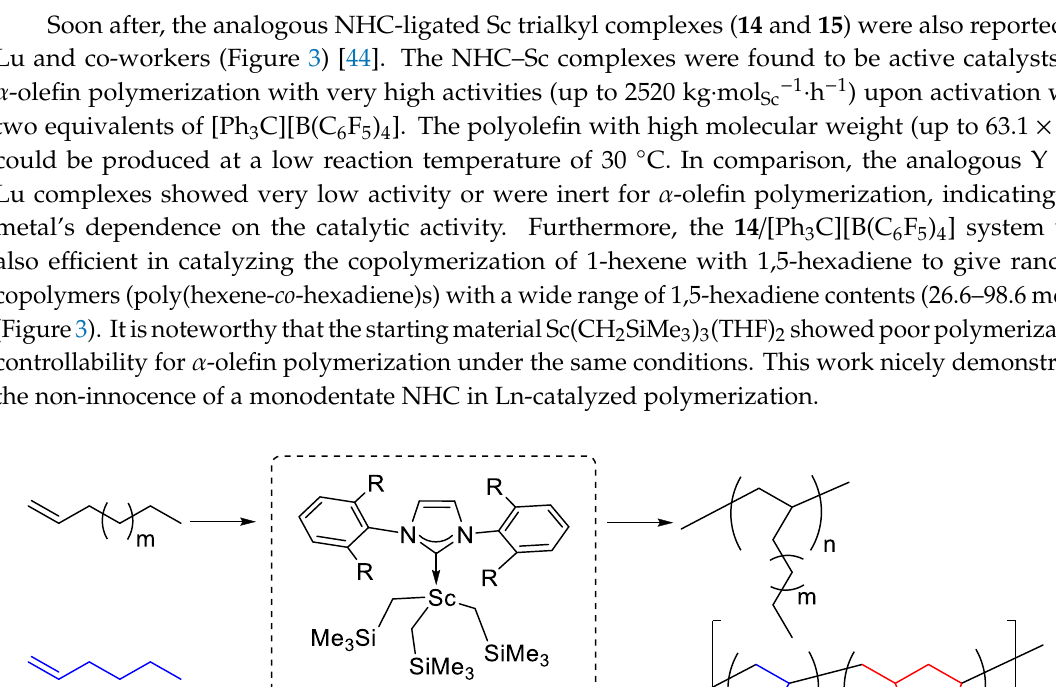
Figure 2. Tri-, dialkyl, or monoalkyl Ln complexes with sterically hindered NHC ligands.